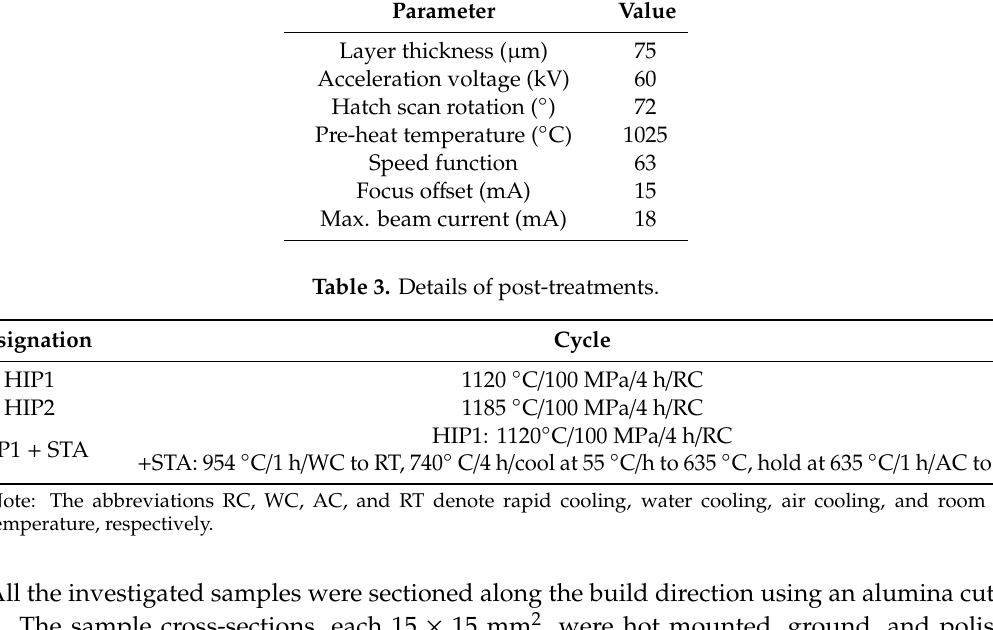
Table 2. Process parameters in the Inco 4.2.205 theme for EBM Alloy 718.